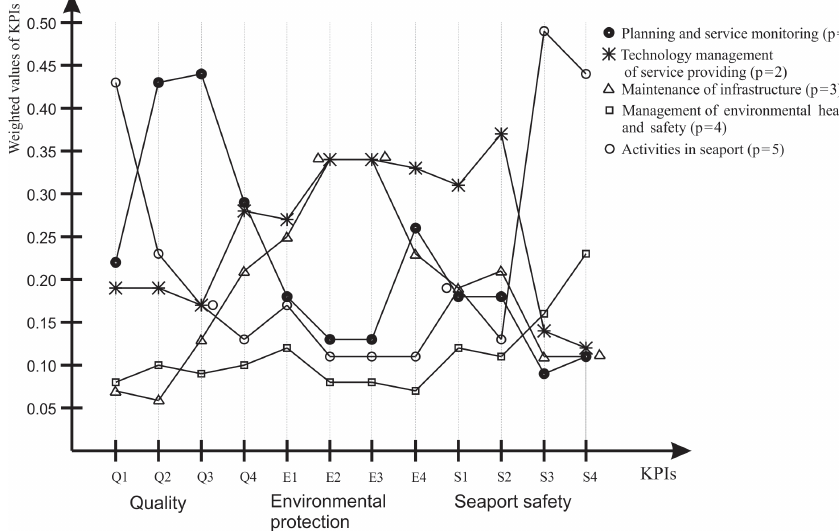
Figure 2. Sensitivity of each business process with respect to the KPIs.